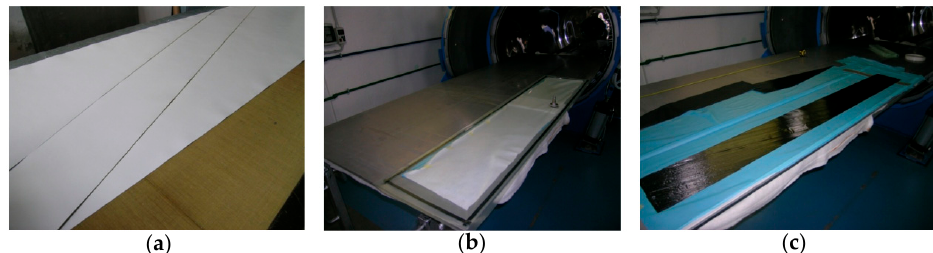
Figure 6. The technology adopted to manufacture the 18° upper and lower skin: ( a ) single ply cutting ( b ) vacuum bagging preparation ( c ) final carbon/epoxy skin.